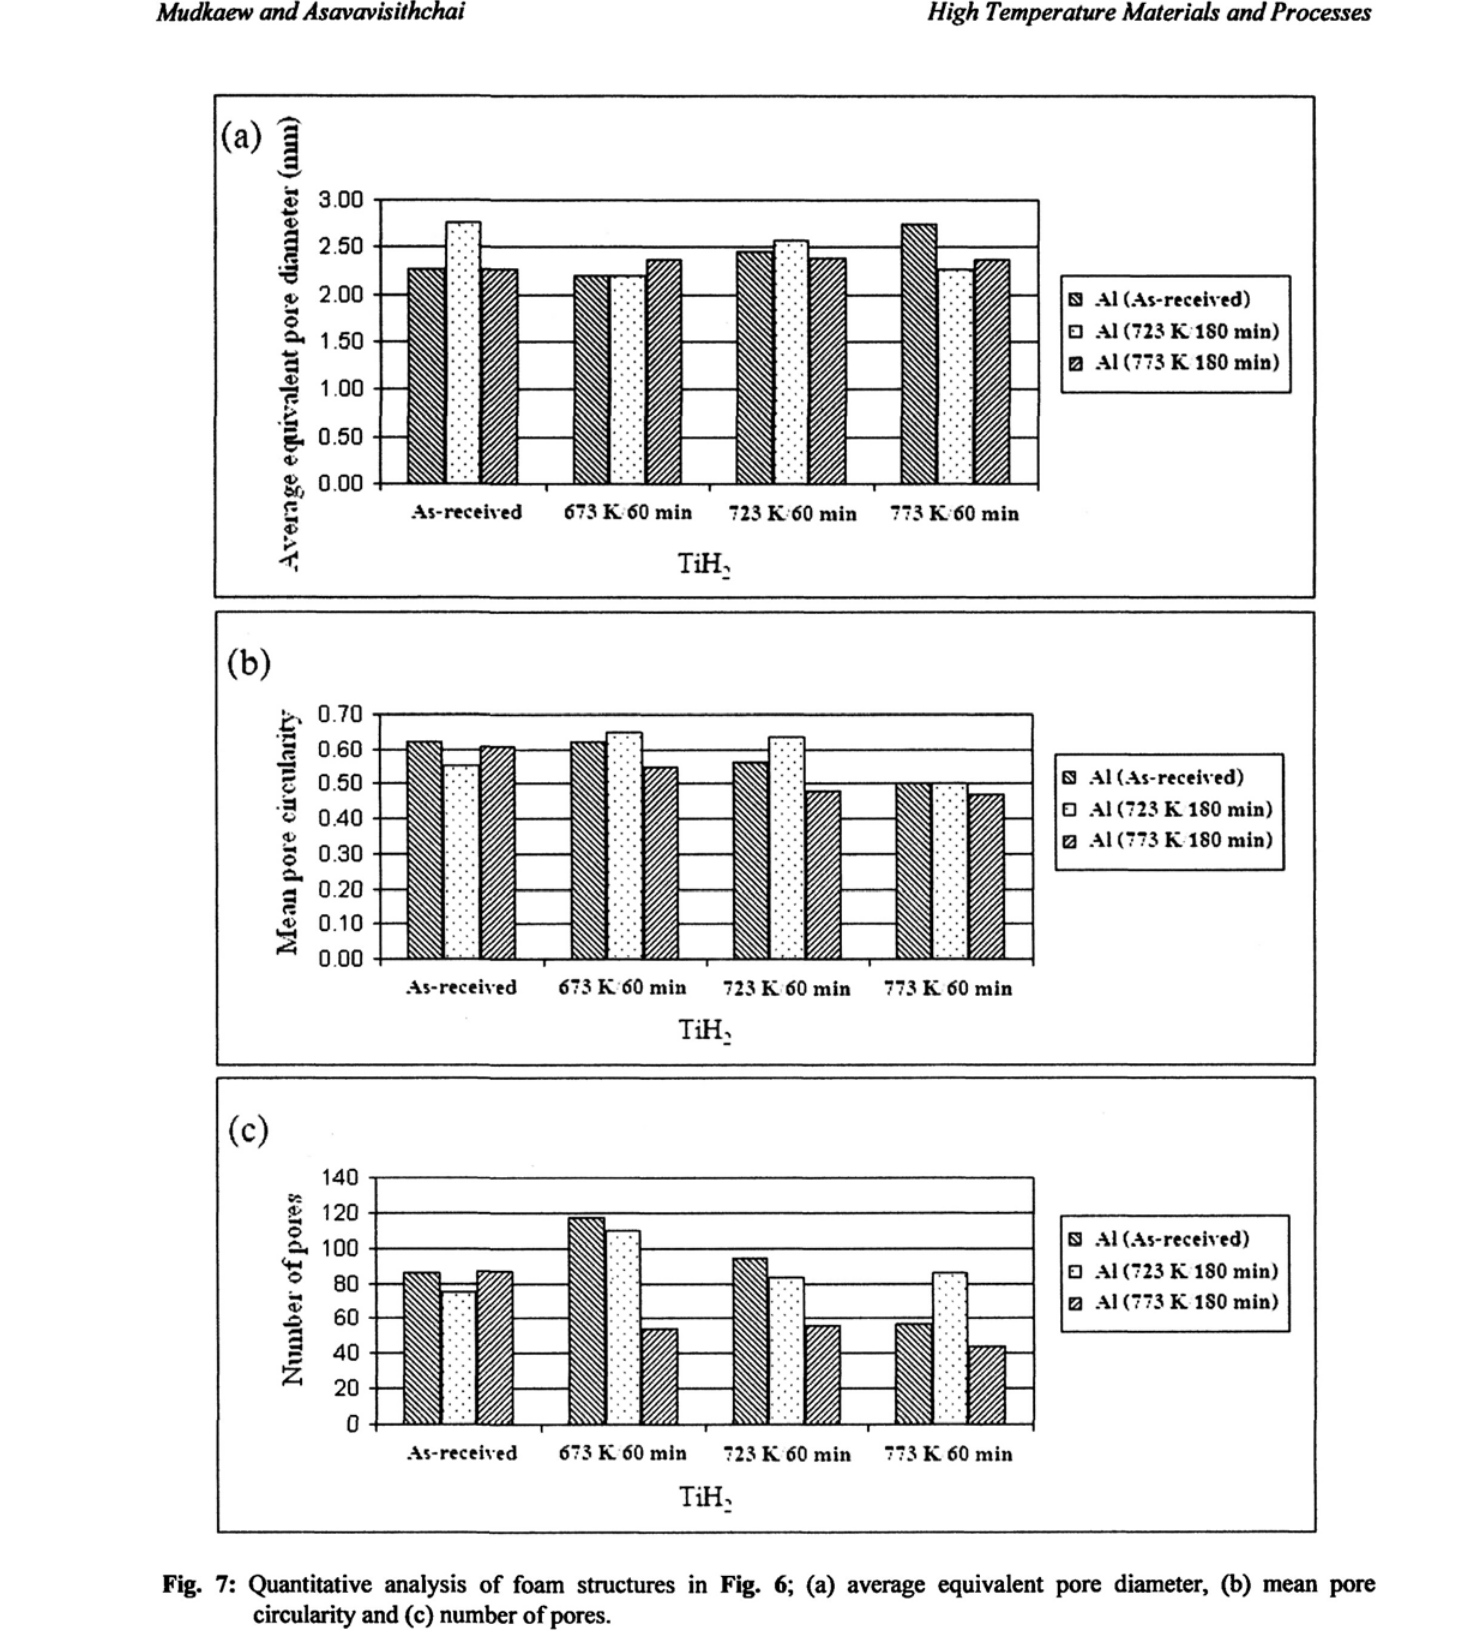
Fig. 7: Quantitative analysis of foam structures in Fig. 6; (a) average equivalent pore diameter, (b) mean pore circularity and (c) number of